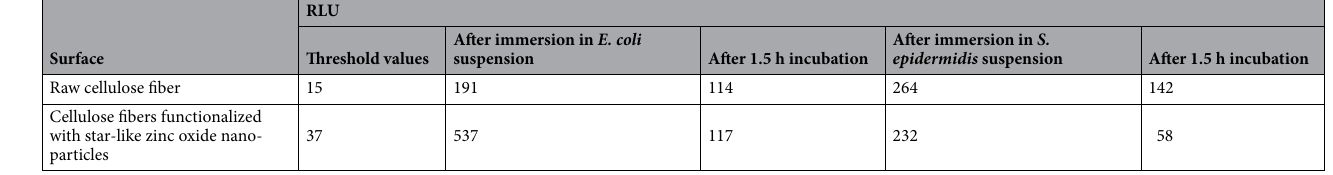
Table 2. ATP bioluminescence based on RLU